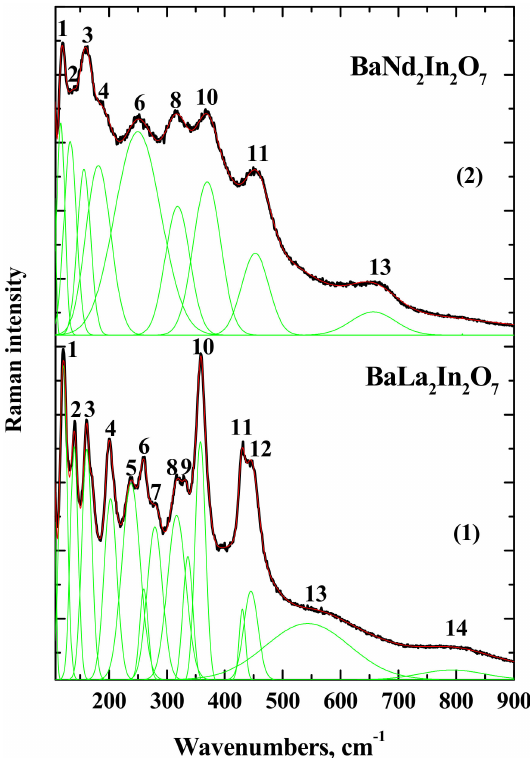
Figure 5. Raman spectra of the BaLa 2 In 2 O 7 ( 1 ) and BaNd 2 In 2 O 7 ( 2 ) compounds. Table 3. Wavenumbers (cm − 1 ) of Raman bands for the BaNd 2 In 2 O 7 and BaLa 2 In 2 O 7 compounds. No of Band BaLa 2 In 2 O